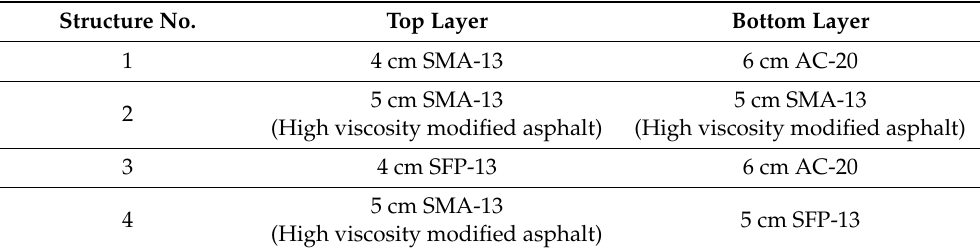
Table 7. Four structures tested in MMLS3 accelerated wheel tracking